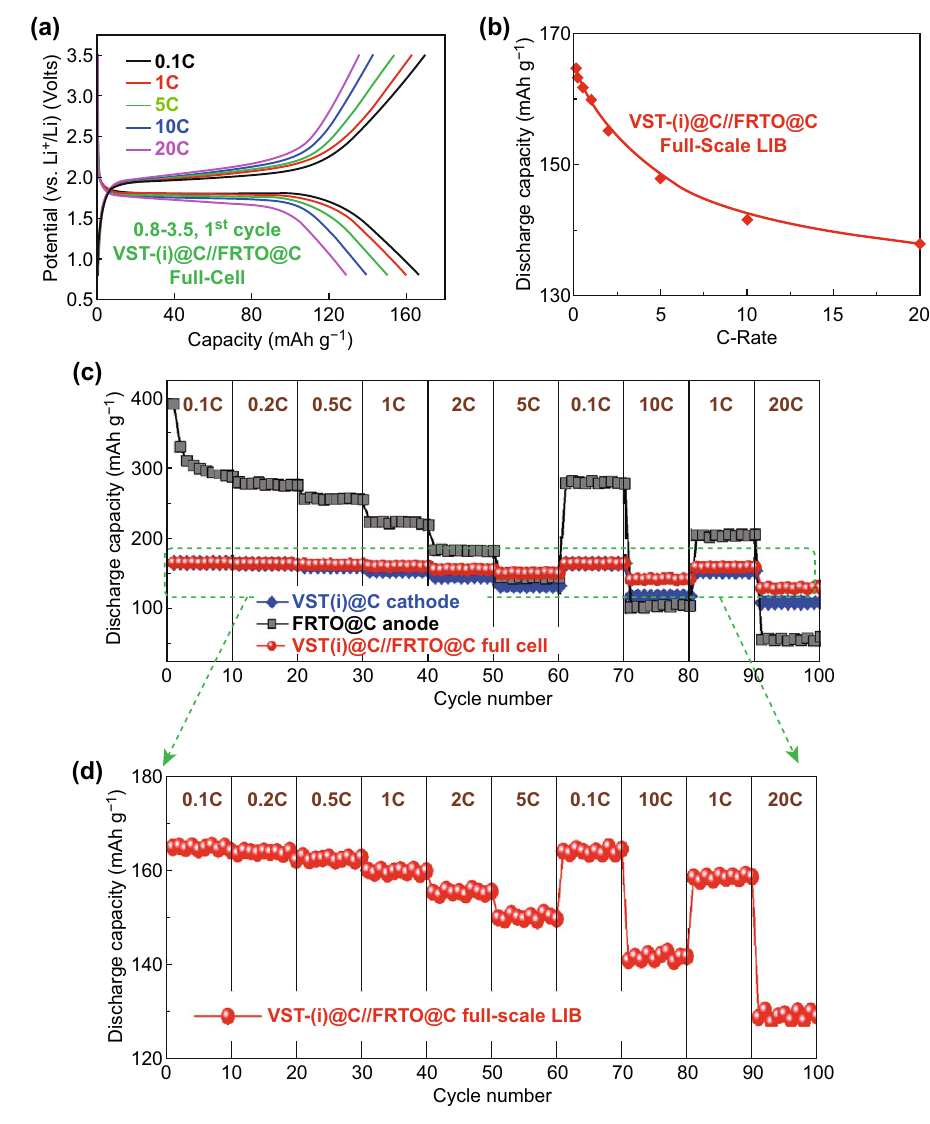
Fig. 5 a Charge–discharge voltage capacity profiles of VST‑(i)@C//FRTO@C full‑scale LIBs at different current rates 0.1, 1, 5, 10, and 20 C. b Behavior of the specific discharge capacity versus current C rates varying from 0.1 to 20 C for a full‑cell VST‑(i)@C//FRTO@C LIB. c Perfor‑ mance and behavior of the rate capability for a powerful in‑built super‑hierarchal full‑scale VST‑(i)@C (cathode)//FRTO@C (anode) at various current rates from 0.1 to 20 C. d Enlargement of the selected part of c for rate capability performance results of the VST‑(i)@C//FRTO@C full cell. All electrochemical measurements were operated within the voltage range of 0.8–3.5 V at room